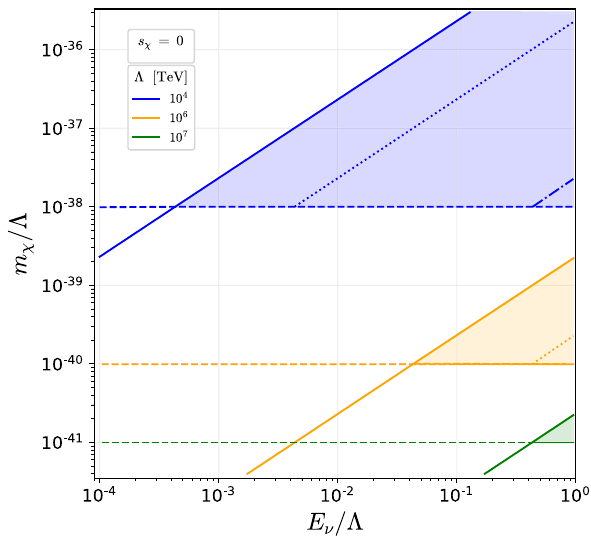
Fig. 1 Regions in the E ν /(cid:7) × m χ /(cid:7) plane in which V p / V 0 (cid:2) 1 (below the solid lines) and m χ (cid:2) 10 − 22 eV (above the dashed lines) are satisfied simultaneously for (cid:7) = 10 4 TeV (blue), 10 6 TeV (orange) and 10 7 TeV (green). The ν DM potential is taken to be the contact one in Eq. (12) and we choose s χ = 0. Below the dotted (dashed-dotted) lines we have V p / V 0 (cid:2) 10 (10 3